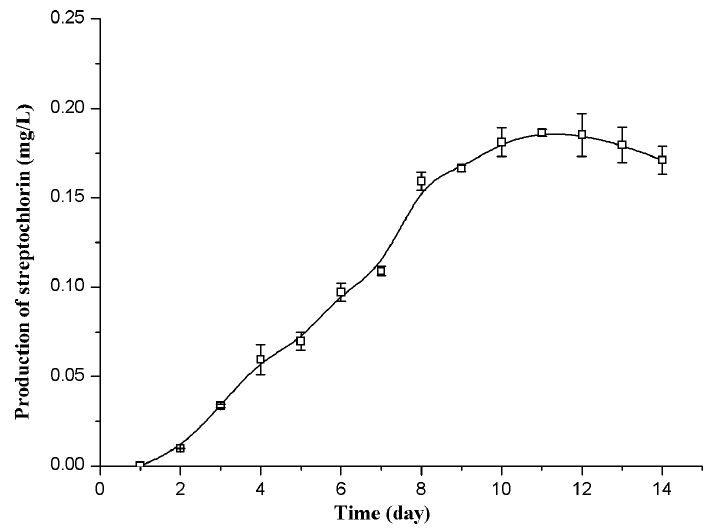
Figure 2. Time courses of streptochlorin production by Streptomyces strain SYYLWHS-1-4 in the flask culture. Table 1. The Plackett-Burman design for screening variables in streptochlorin production.